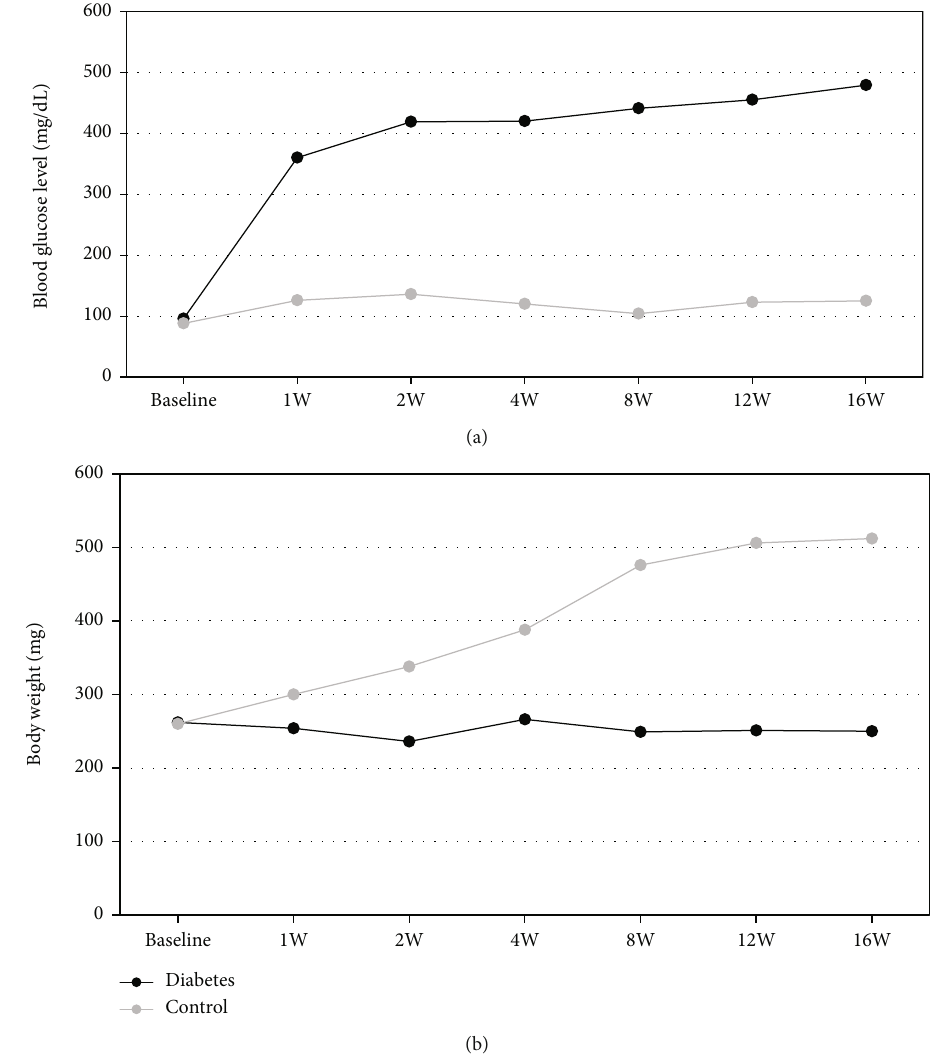
Figure 1: (a) Blood glucose levels (mg/dL) and (b) body weight of control and diabetic